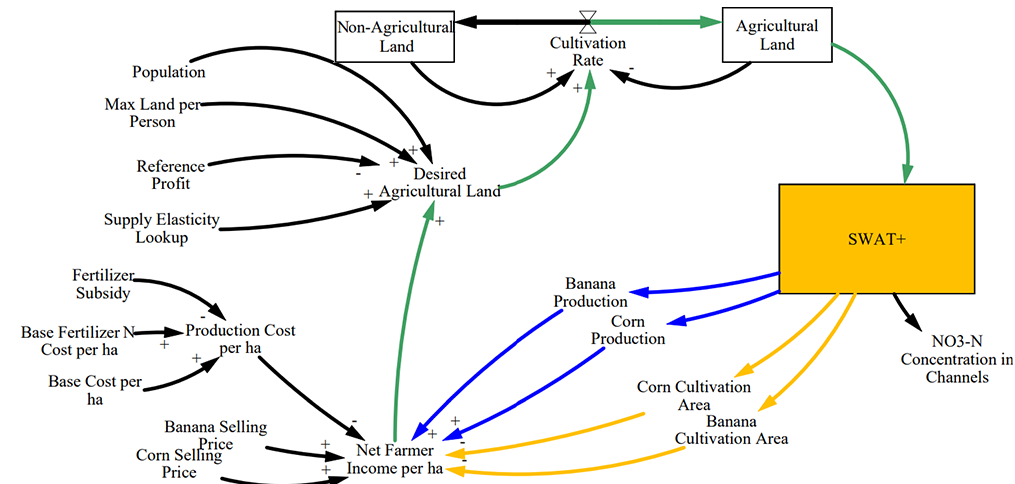
Figure 3. Representation of the case study model as a causal loop diagram. The main loops are represented in blue for the loops of banana production (rBP) and corn production (rCP), yellow for the loops of corn cultivation area (bCCA) and banana cultivation area (bBCA), and green for the overlapping parts of all loops. This figure is adapted and substantially modified from Harms et al.